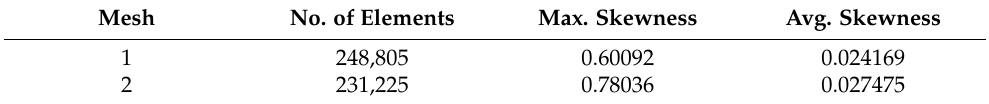
Table 3. Selected mesh